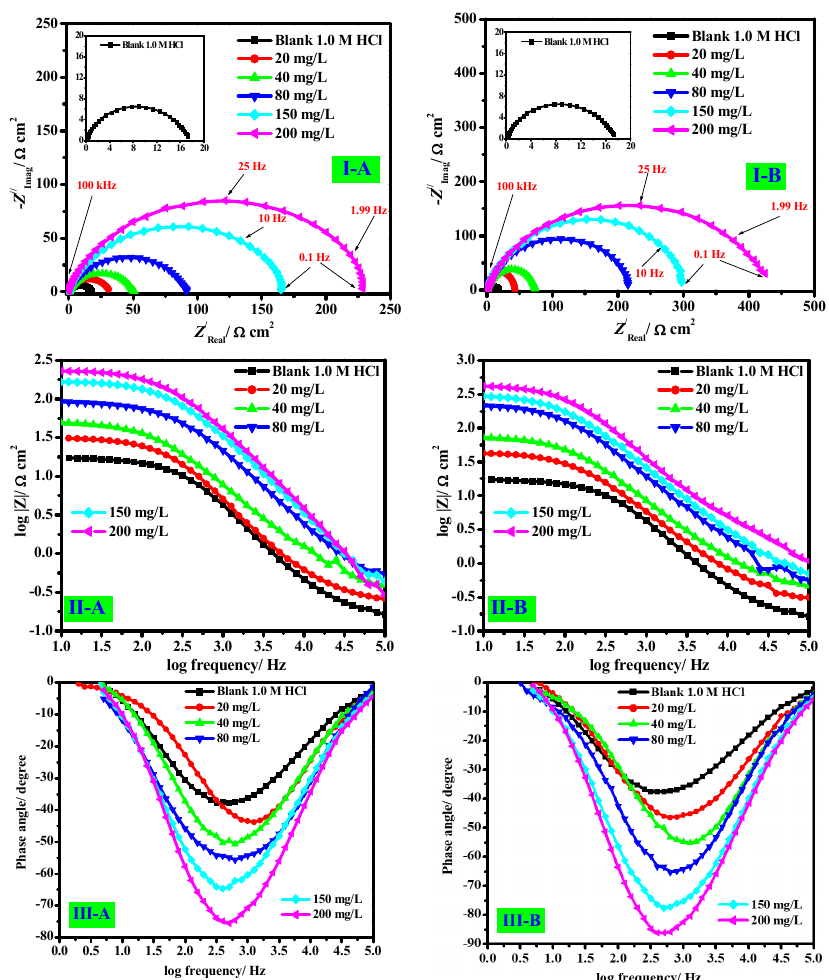
Figure 4. Nyquist profiles ( I ) for C-steel in molar HCl in the lack and in the occurrence of the different doses ( A ) Ad-Th and ( B ) Fe-Th at 50 °C. ( II ) Bode module and ( III ) bode phase diagrams.